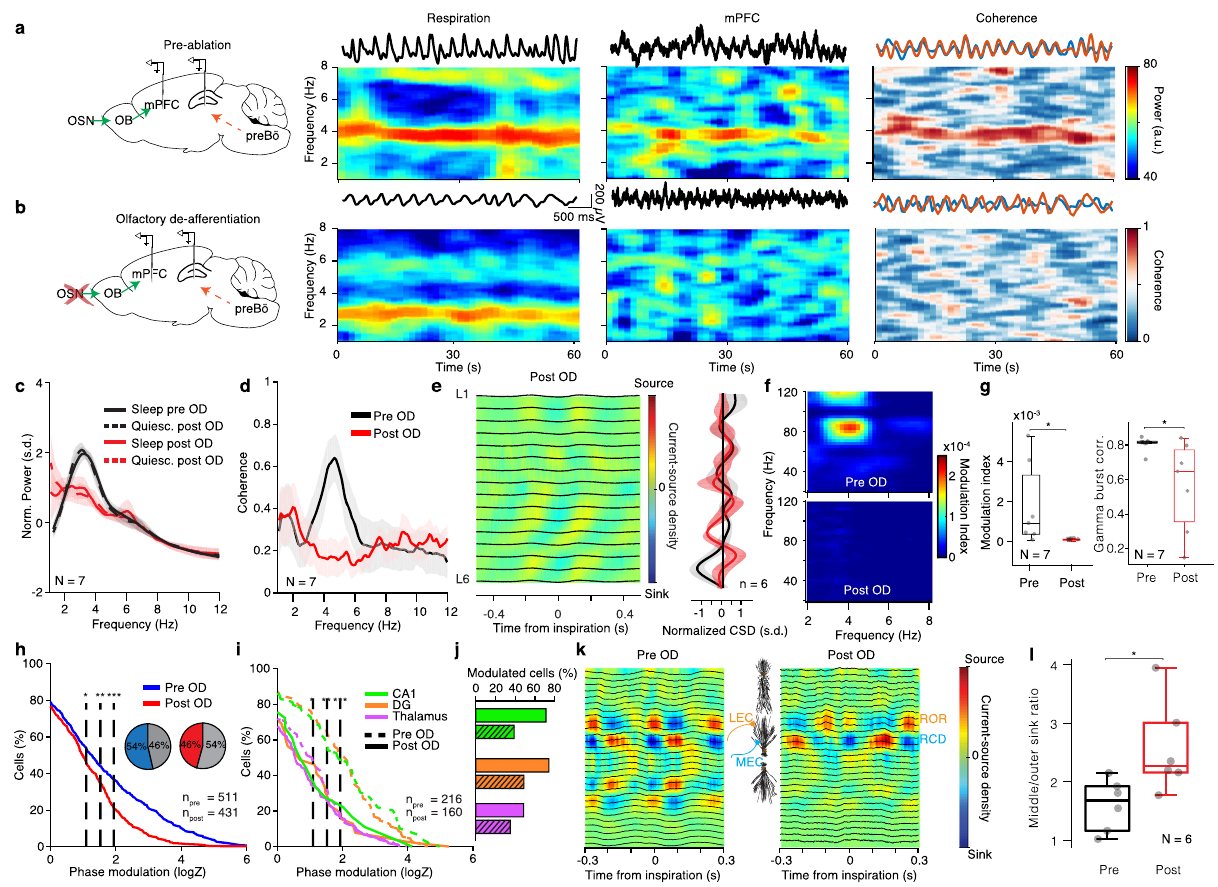
Fig. 5 Reafferent respiratory input underlies respiratory LFP entrainment. a , b Left, schematic of the manipulation strategy. Right, for example time- frequency decomposition of power and coherence between respiratory and mPFC LFP signals during quiescence before ( a ) and after ( b ) OD. c Average normalized mPFC power spectra before and after OD ( N = 7 head- fi xed mice). d Coherence spectrum between respiration and mPFC LFP before and after OD ( N = 7 mice). e Left, example inspiration-triggered CSD of the mPFC LFP during quiescence and sleep after OD. Right, average normalized CSD at zero- lag ( N = 6 mice). f Example power-phase modulation of mPFC gamma oscillations before (top) and after (bottom) OD. g Average mPFC power-phase modulation strength of ~80 Hz gamma oscillations (left) and gamma burst cross-correlation between mPFC and OB bursts (right) ( N = 7 mice; Wilcoxon signed-rank two-sided test: before vs. after OD, P = 0.0312). h Cumulative distribution of modulation strength for all mPFC neurons pre and post-OD (Pre: n = 511 cells; Post: n = 431 cells). Inset, percentage of signi fi cantly phase-modulated cells before and after OD. i Cumulative distribution of modulation strength for CA1, DG, and somatic thalamus neurons before and after OD. j Percentage of signi fi cantly phase-modulated cells before and after OD. k Example inspiration-triggered CSD of the dorsal hippocampus LFP before (left) and after (right) OD. l Average ratio of the middle to outer molecular layer sink depth ( N = 6 head- fi xed mice; Wilcoxon two-sided signed-rank test: before vs. after OD, P = 0.0312). Shaded areas, mean ± SEM arb. units arbitrary units, s.d. standard deviations, n.s. not signi fi cant. Shaded areas, mean ± SEM. Stars indicate signi fi cance levels (* P < 0.05; ** P < 0.01; *** P < 0.001). s.d. standard deviations, arb. units arbitrary units, OD olfactory deafferentation. For box plots, the middle, bottom, and top lines correspond to the median, bottom, and top quartile, and whiskers to lower and upper extremes minus bottom quartile and top quartile, respectively. Source data are provided as a Source Data fi